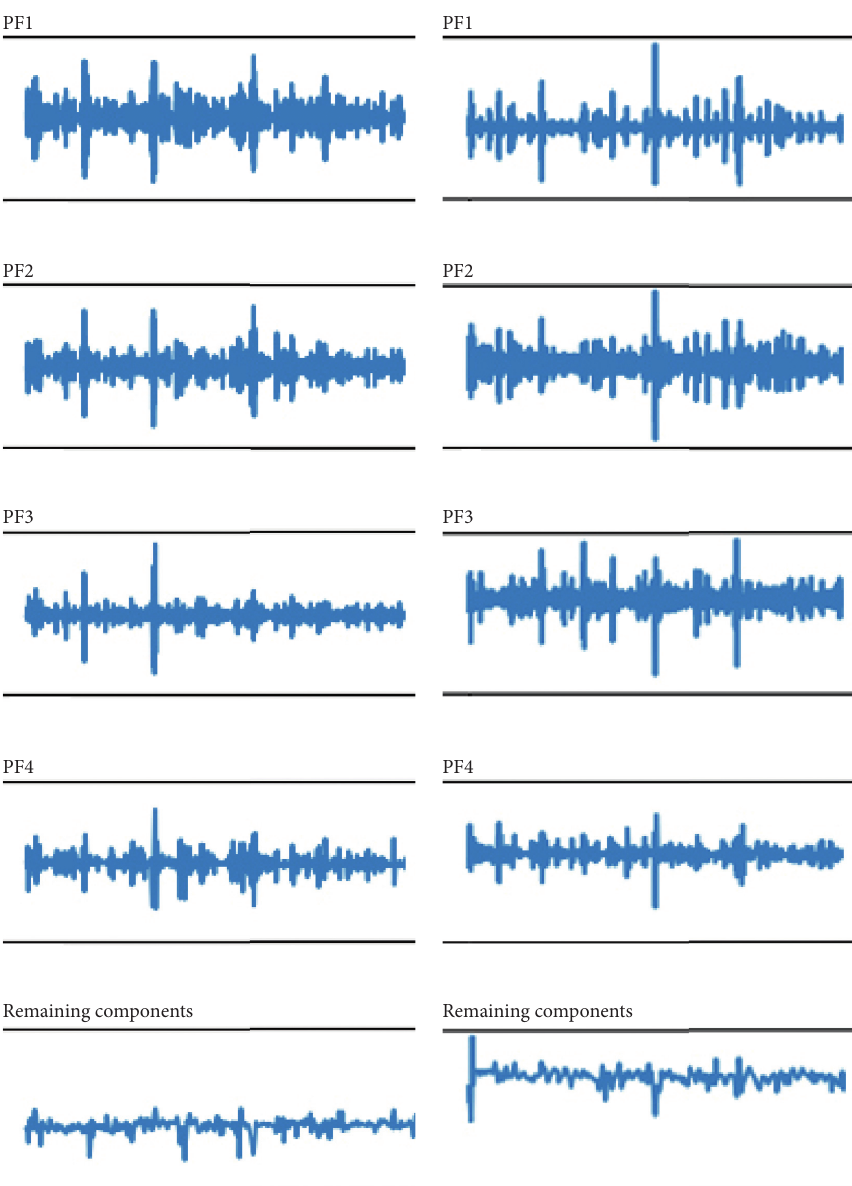
Figure 2: Decomposition components of two vibration